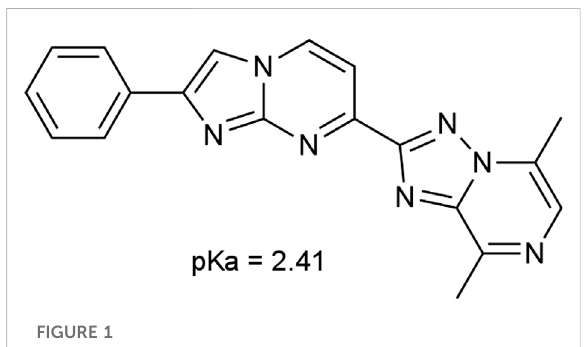
FIGURE 1 Chemical structure of